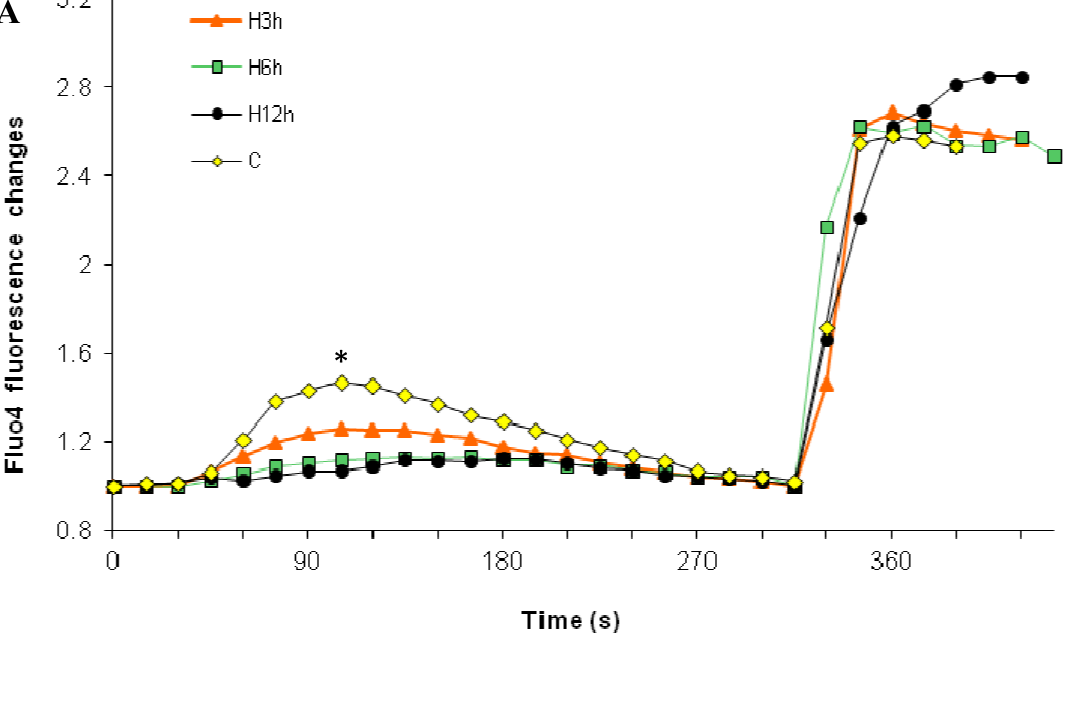
Figure 1. Effects of high dose paclitaxel on the cell’s ability to influx external Ca 2+ . Under normal calcium conditions, cells were analyzed after treatment of high dose paclitaxel at 10 − 6 M (3, 6, and 12 h). Arrows show the addition of 3 μ M TG at 15 s and 2 mM CaCl at 300 s. ( A ) Time-response curve (mean) was determined from data generated in three independent tests; ( B ) From the top curve, peak levels of capacitative calcium entry (CCE), external Ca 2+ influx, were represented by mean ± SD and statistical analysis was performed; ( C ) From the top curve, levels of CCE at 100 s, indicated by